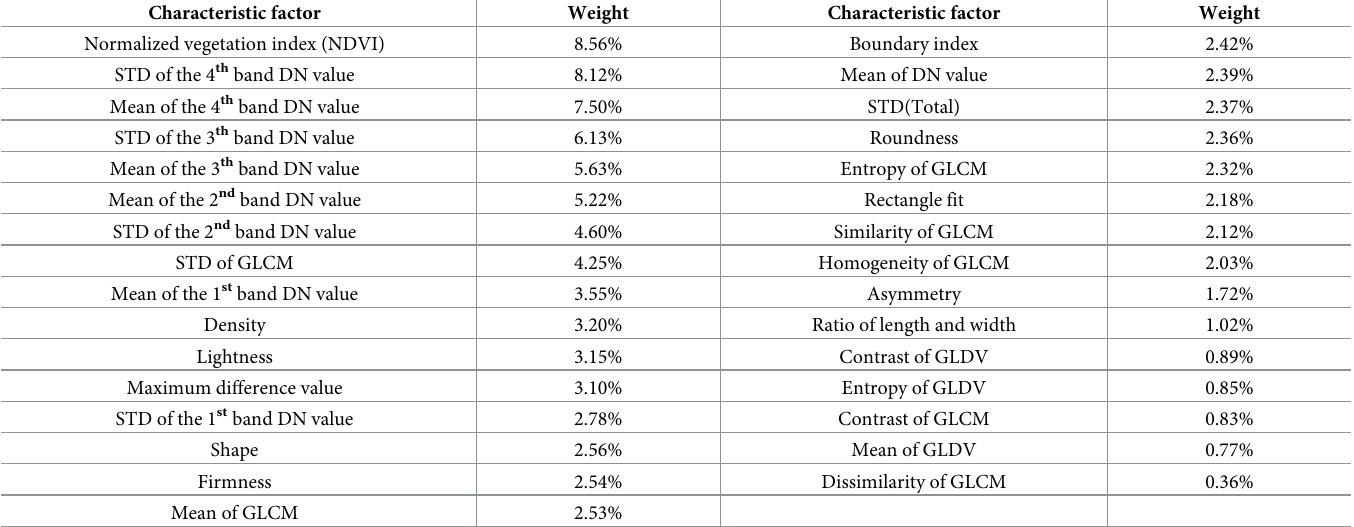
Table 6. Feature factors importance ranking of RF model.